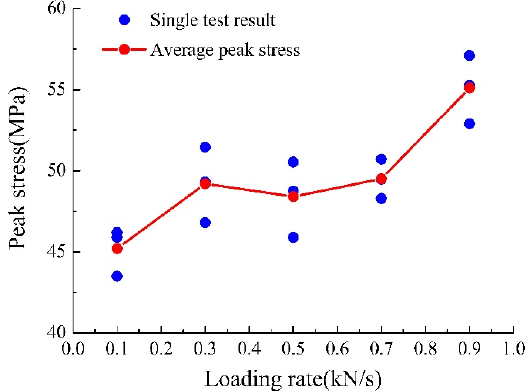
Figure 5. Yellow sandstone’s peak strength under different loading rates.